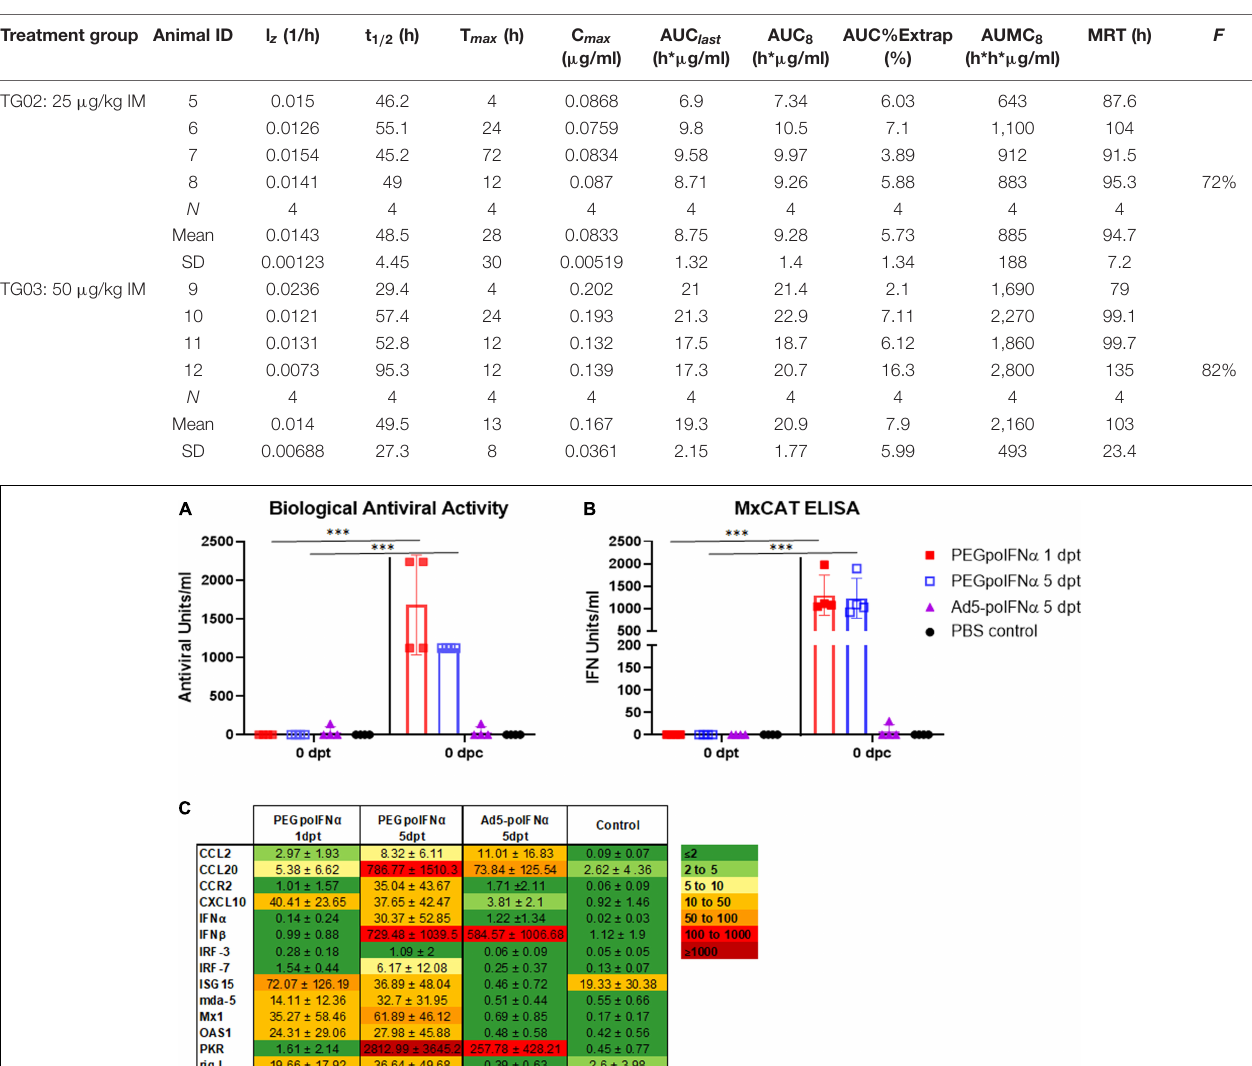
TABLE 3 | Individual and mean pharmacokinetics parameters for PEGpoIFN α in swine plasma following intramuscular administration. Treatment group Animal ID